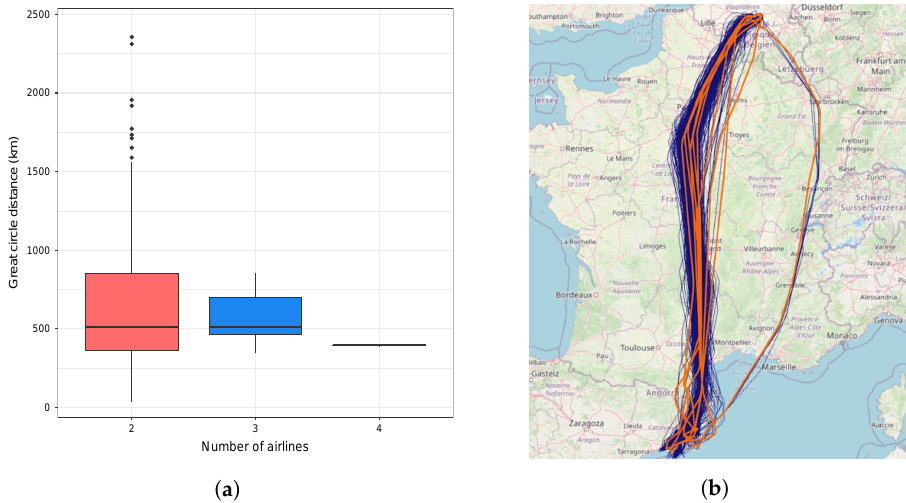
Figure 8. Distribution of GCD for Not dependent, one cluster ODs, and an example of Not depen- dent, multiple clusters for an OD. ( a ) Distribution of GCD for OD pairs with one trajectory cluster; ( b ) trajectory clusters between Brussels and Barcelona.